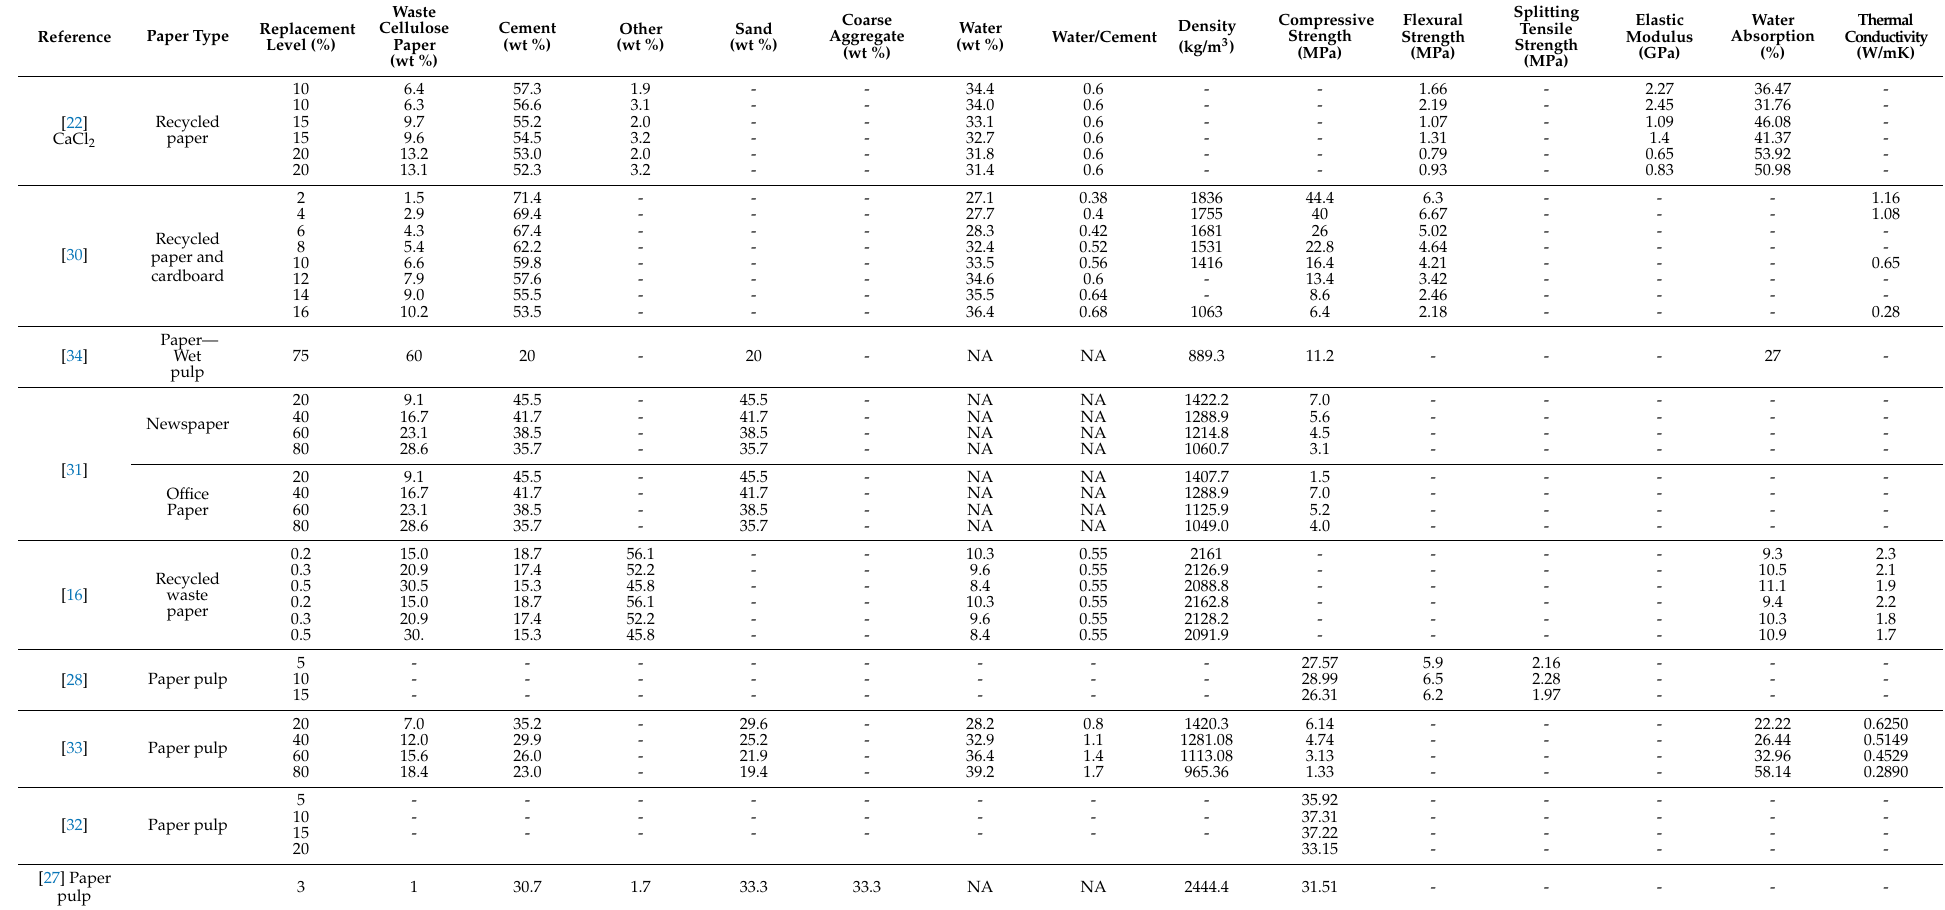
Table 5. Mix design and performance of cellulose waste (waste paper and cardboard) cement-based